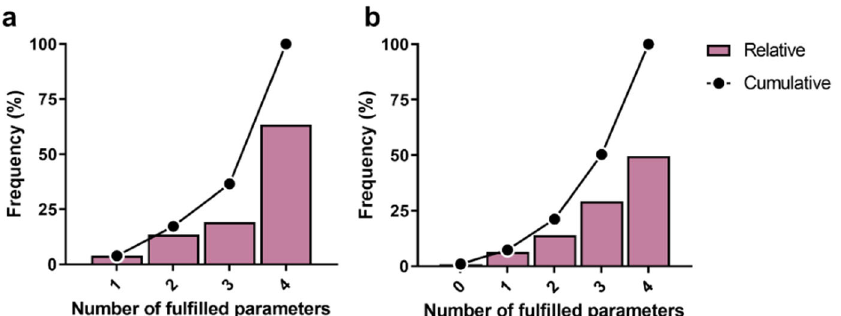
Figure 2. Skin permeability features of UV filters and Streptomyces -derived compounds. The MW, H- acceptors, cLogP, and cLogS parameters were calculated for the AUVFs (n = 50) and the Streptomyces - derived compounds (n = 6524). The compounds were classified according to the number of met parameters as bad penetrants (i.e., molecules with MW > 213, H-acceptors ≥ 3, cLogP > 1.2, and/or cLogS < − 1.6). In the plots, X -axis represents the number of parameters, and Y -axis represents the percentage frequency (bars to the relative frequency and dots to the cumulative frequency). ( a ) Approved organic UV filters group; ( b ) StreptomeDB 3.0 database compounds.